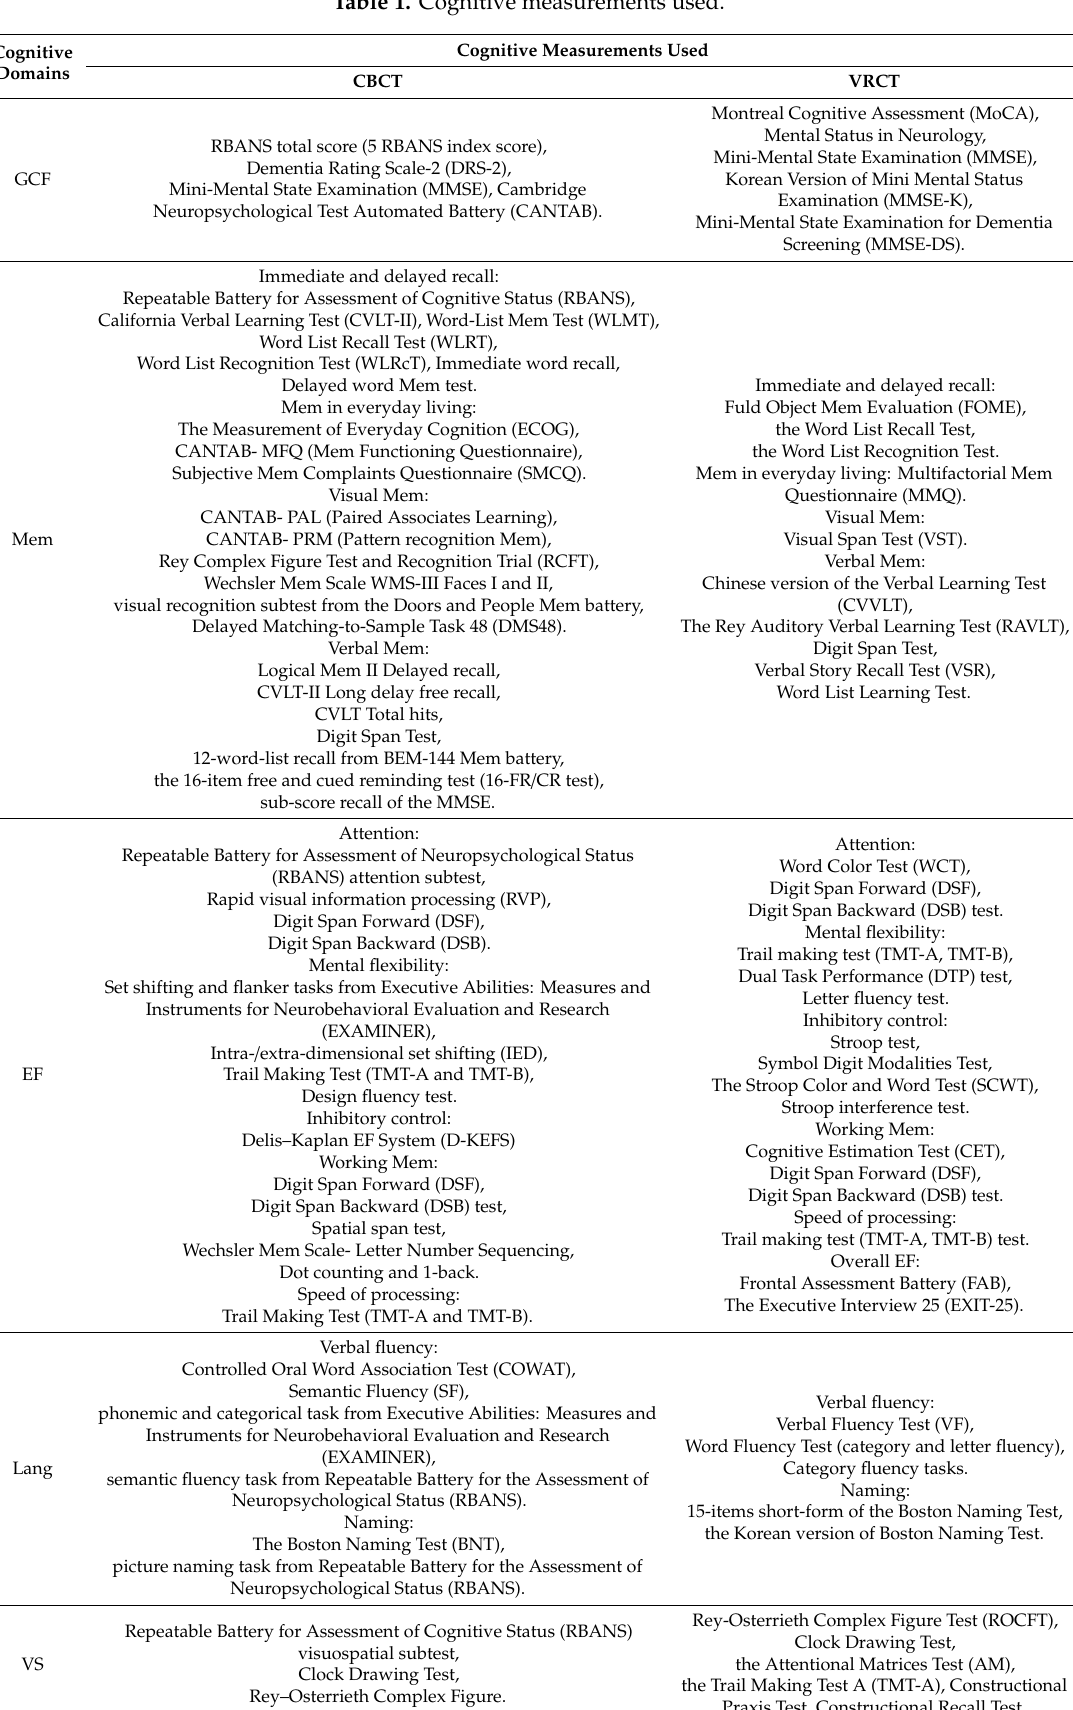
Table 1. Cognitive measurements used.